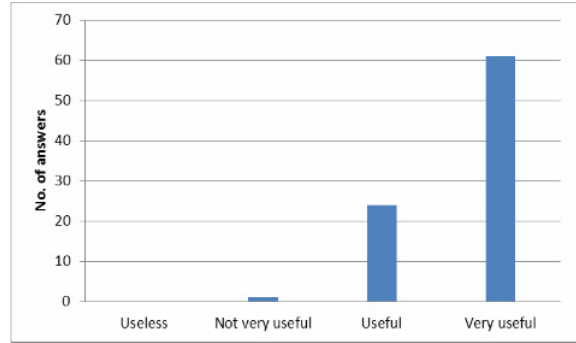
Figure 4. Results of Question 1